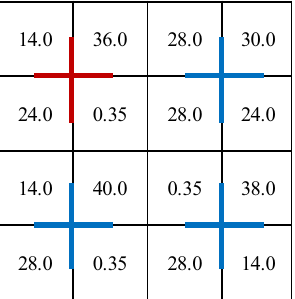
Figure 6. 4-by-4 SVEA-96 Optima2 mini core configuration with burnup values (in GWd/t) and location of the control blades (red cross: partially inserted from the bottom, blue crosses: